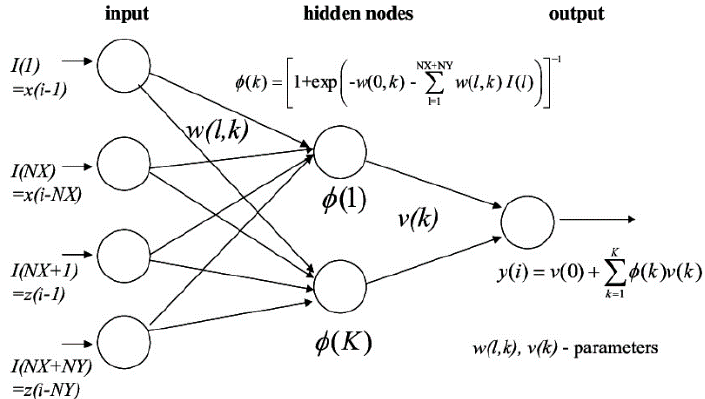
Figure 2. A two-layer feedforward neural network.